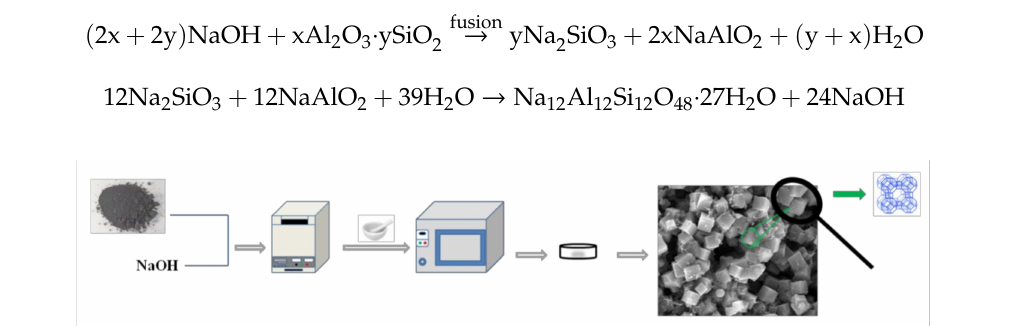
Figure 1. Flow chart of single-phase A zeolite